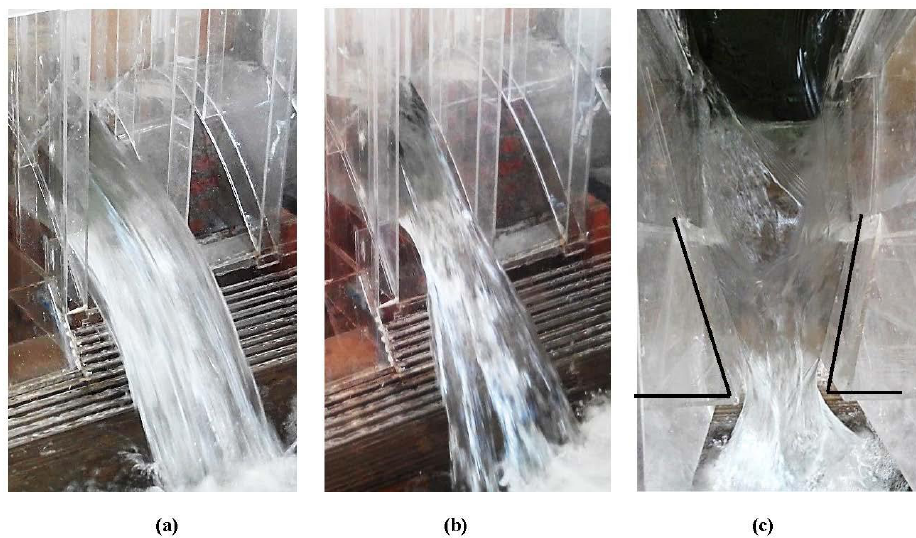
Figure 3. Photograph of the plunging jets in the present study ( H = 0.3 m): ( a ) without FGP ( β = 1); ( b ) with FGP ( β = 0.51, θ = 15°); ( c ) with FGP ( β = 0.51, θ = 15°).